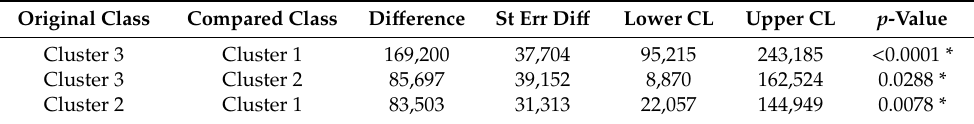
Table 10. Ordered di ff erences report for latent